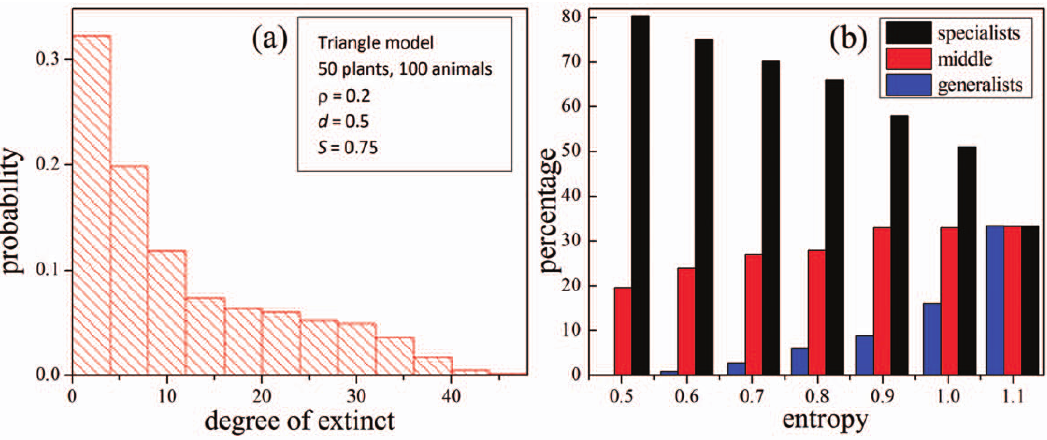
Figure 6. Entropy illustration. a) Distribution of the degree of the extinct species in a typical situation (1000 realizations). b) Typical distributions and the entropies that measure their degree of uniformity.